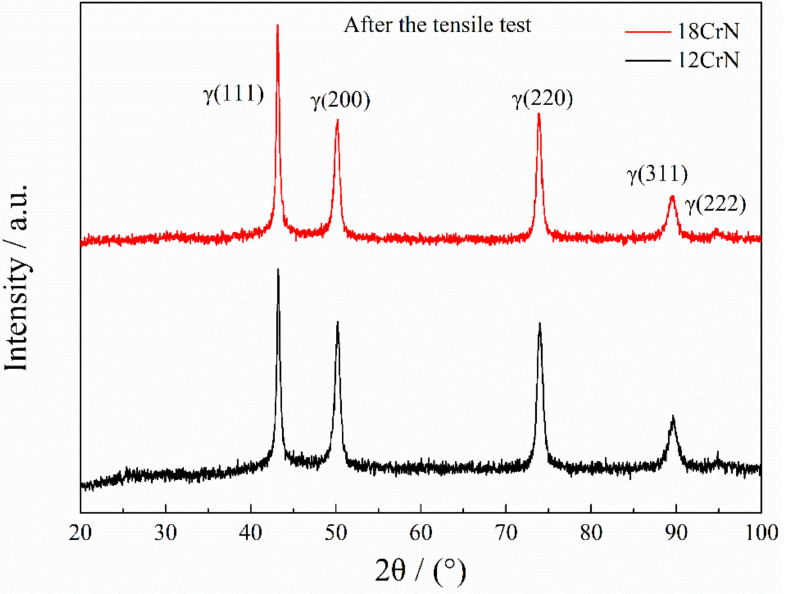
Figure 2. XRD patterns of Fe–Mn–Cr–CN TWIP steels after the tensile